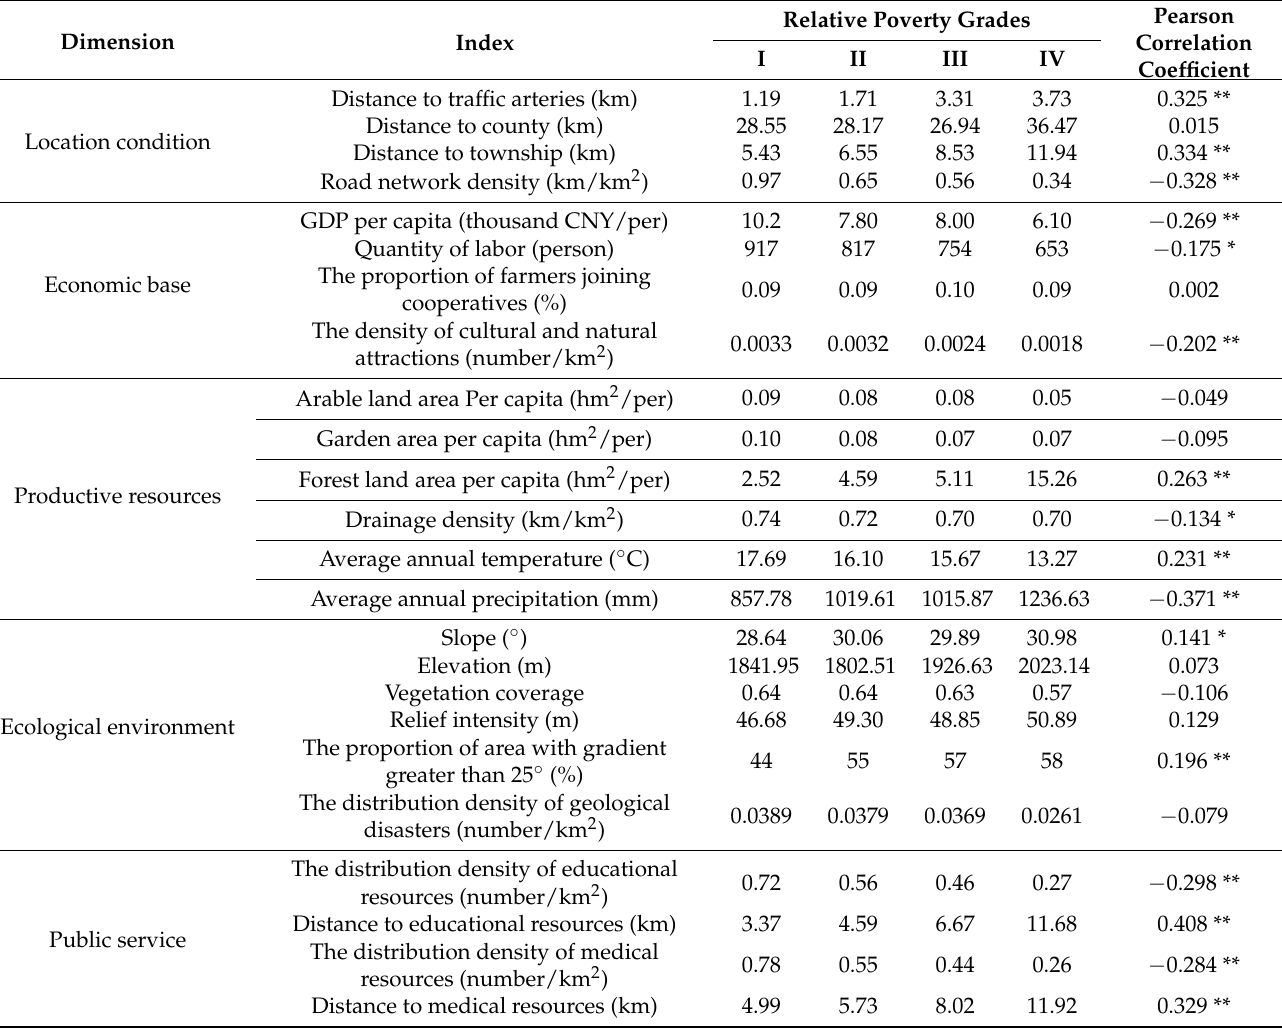
Table 4. Indicators of different poverty degrees in relatively poverty